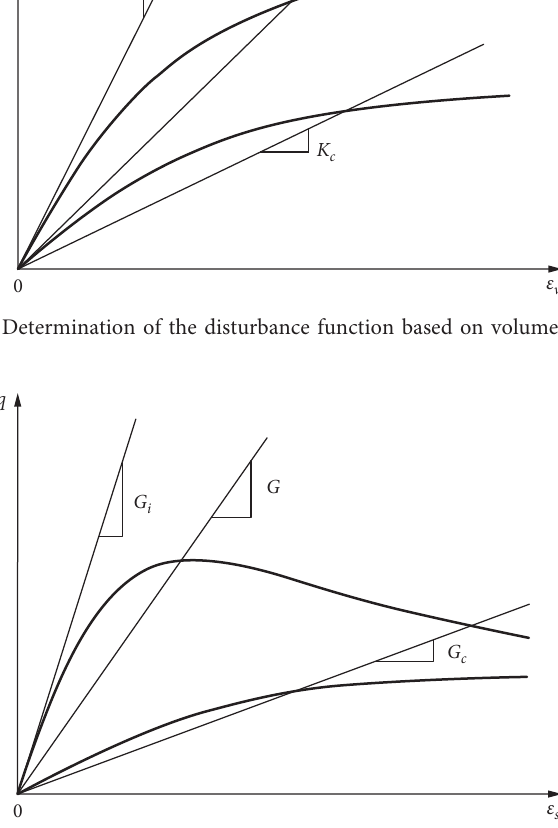
Figure 5: Determination of the disturbance function based on shear